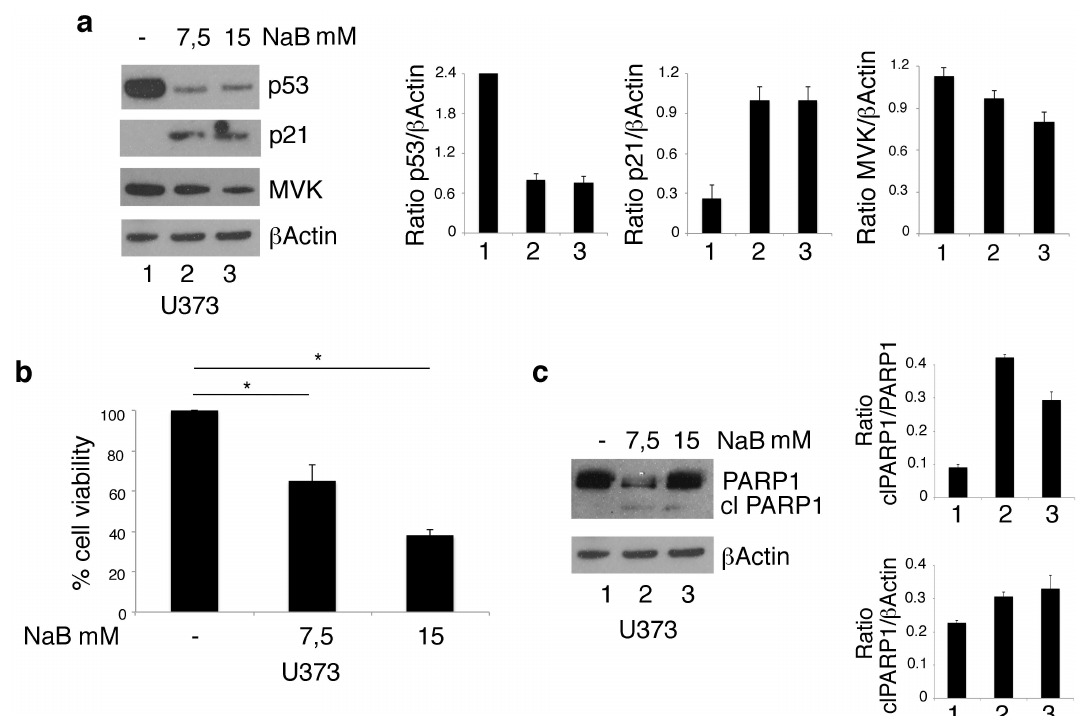
Figure 3. NaB downregulates mutp53 expression level and reduces cell viability in U373 glioblastoma cells. p53 and p21 protein expression ( a ) was analyzed by Western blot of U373 cell line cultured in the absence or in the presence of 7.5 or 15 mM NaB for 24 h. β Actin was used as loading control. One representative experiment out of 3 is shown. The histograms represent the mean plus SD of the densitometric analysis of the ratio p53 / β Actin[SL1] and p21 / β Actin; cell survival of U373 cell line cultured in the absence or in the presence of 7.5 or 15 mM NaB for 24 h was evaluated by trypan blue exclusion assay ( b ). The histograms represent the mean plus SD of more than 3 experiments * p -value < 0.05; ( c ) cleavage of PARP1 (clPARP1) was analyzed by Western blot of U373 cell line cultured in the absence or in the presence of 7.5 or 15 mM NaB for 24 h. β Actin was used as loading control. One representative experiment out of 3 is shown. The histograms represent the mean plus SD of the densitometric analysis of the ratio of clPARP1 / PARP1and clPARP1 / β